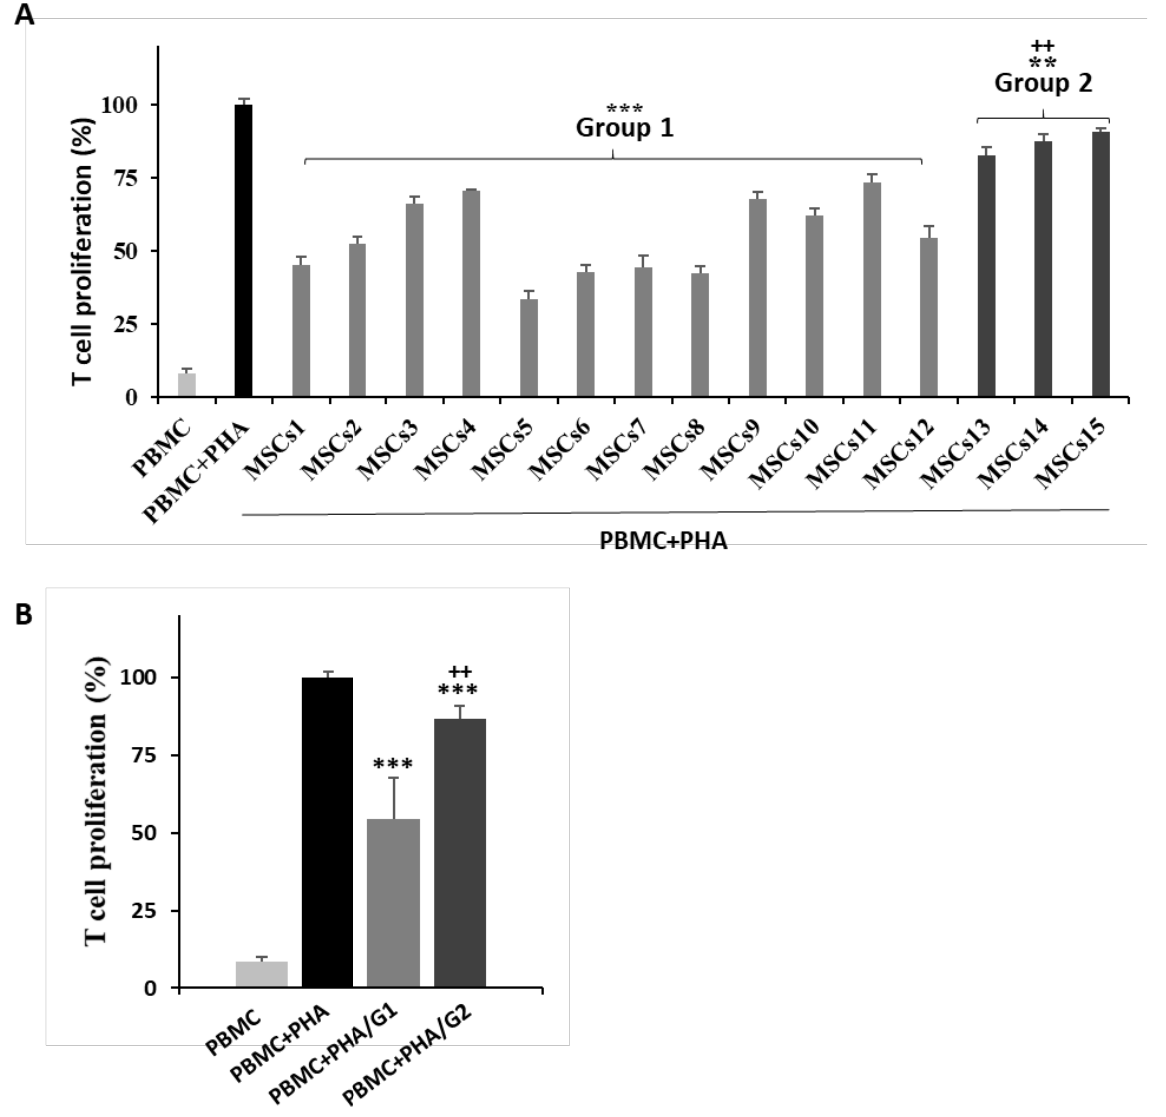
Figure 3. Effect of UCB-MSCs on human T cell proliferation in the MLR assay. PHA-stimulated PBMCs were co-cultured with MSCs for 3 days. ( A , B ) The proliferation of T cells is shown as a percentage relative to the positive control (PBMC + PHA; set to 100%). Fifteen different MSCs were evaluated to confirm their T cell-suppressive effects. All MSCs suppressed T cell proliferation. Based on MLR assay results, MSCs were classified two groups depending on the extent of T cell suppres- sion; namely, Group 1 (MSCs1 to MSCs12) and Group 2 (MSCs13 to MSCs15). ( A ) Error bars repre- sent means ± SD, n = 5 per group; *** p < 0.001, ** p < 0.01 vs. PBMC + PHA, ++ p < 0.01 vs. Group 1. ( B ) Data are presented as the mean ± SD for n = 5 (PBMC, PBMC + PHA), n = 60 (PBMC + PHA/G1), or n = 12 (PBMC + PHA/G2) per group; *** p < 0.001 vs. PBMC + PHA, ++ p < 0.01 vs. PBMC + PHA/G1. PBMC: peripheral blood mononuclear cell; PHA: phytohemagglutinin; G1: Group 1; G2: Group 2.